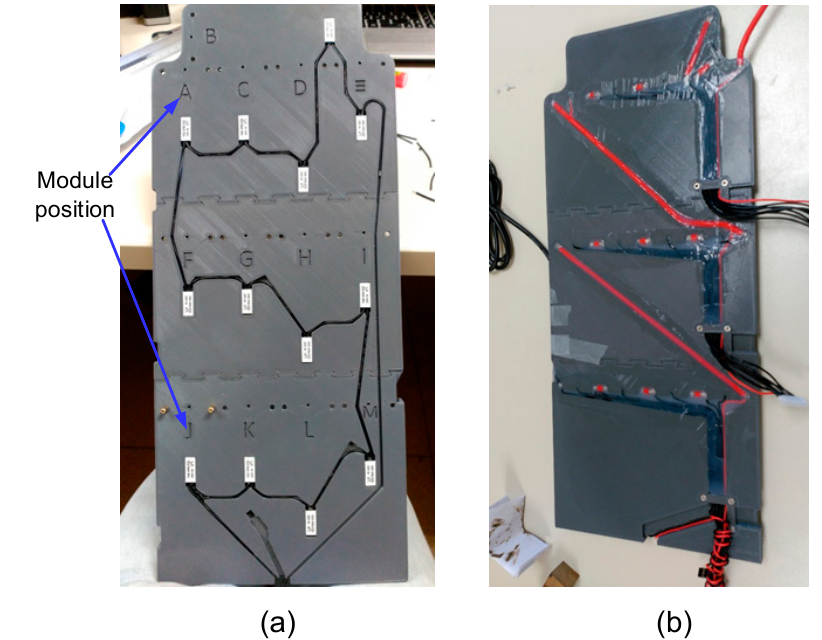
Figure 7. Current collector codification ( a ) and connections ( b ).